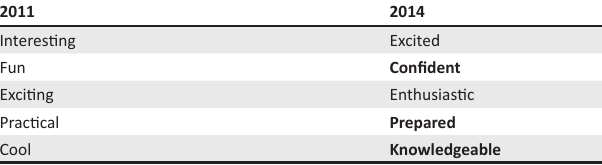
TABLE 1: Dominant words in the 2011 and 2014 word